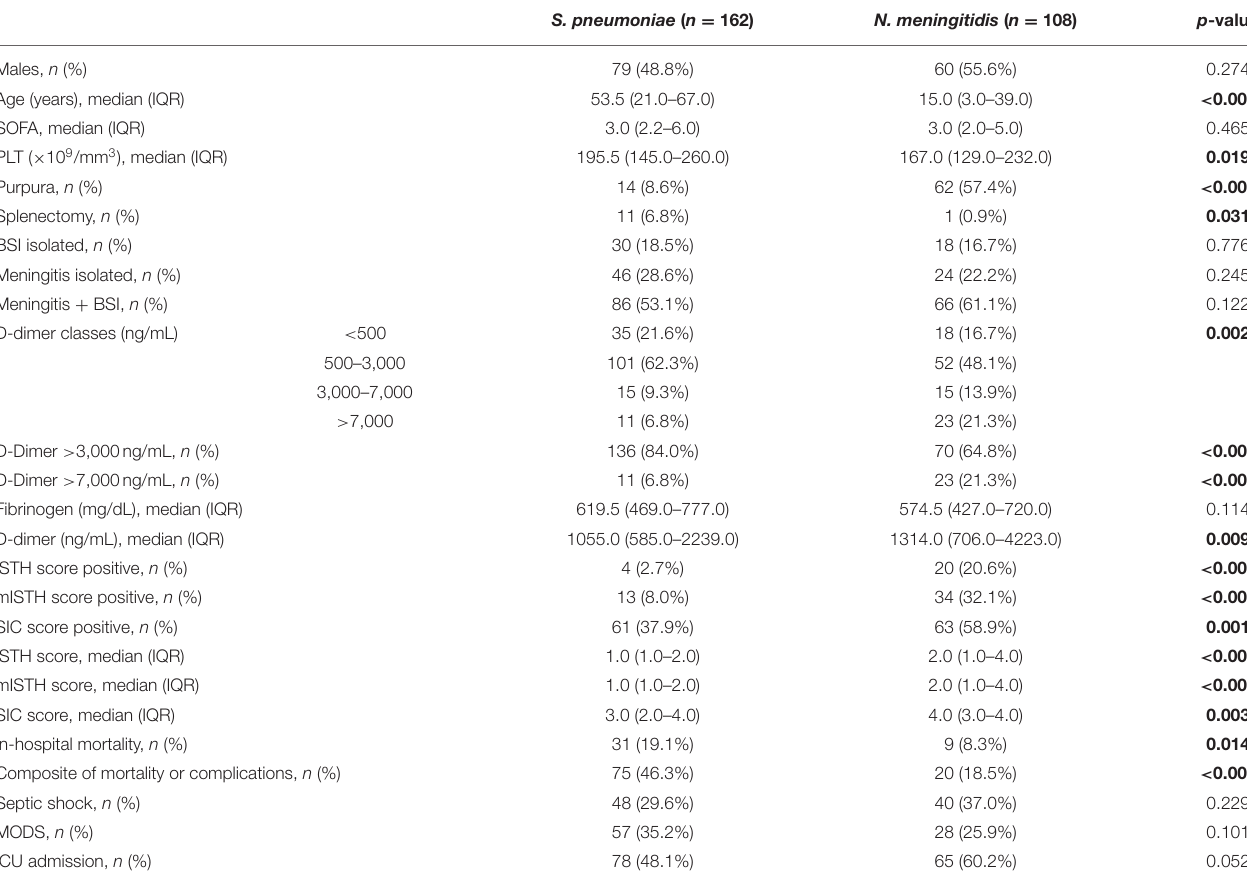
TABLE 1 | Analysis of variables for different